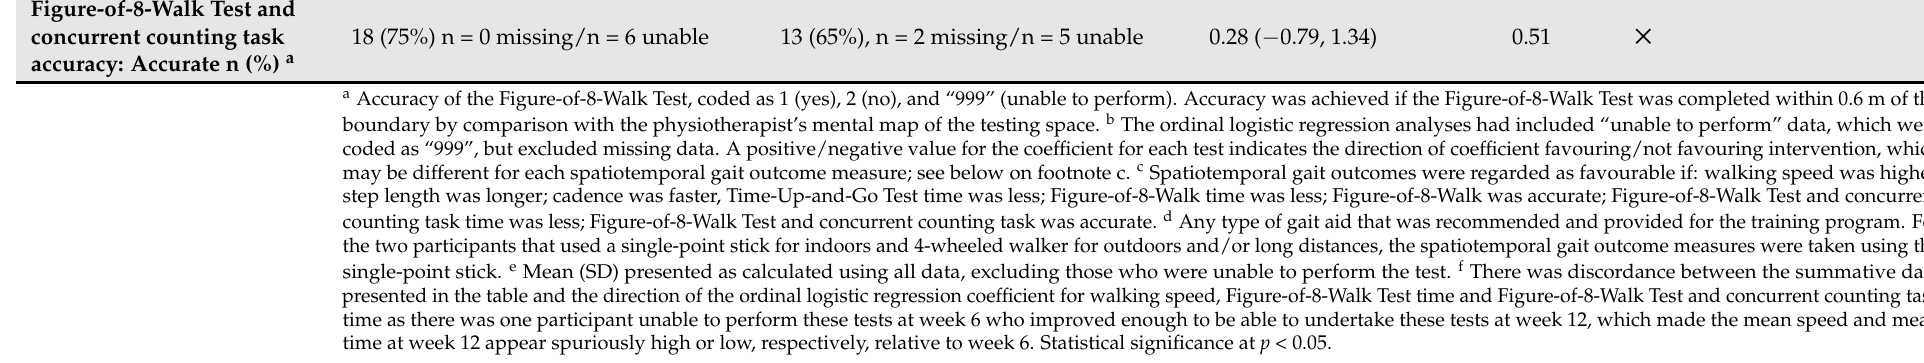
Figure-of-8-Walk Test and concurrent counting